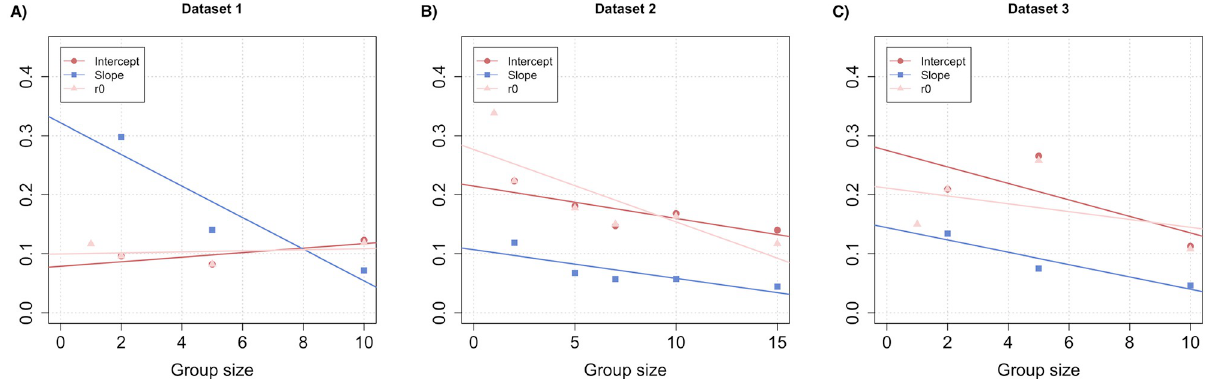
Fig 6. Slopes, intercepts and r0 values of the alarm pheromone dose-response curve as a function of group size, for all 3 datasets. The slopes and intercepts are based on the linear model, while the r0 value is estimated from the agnostic model. Pearson’s r test; dataset 1 (A): slopes ρ = − 0.9332609, p = 0.1169501, intercepts ρ = 0.7495004, p = 0.7697062, r0 ρ = 0.2101355, p = 0.6050677; dataset 2 (B): slopes ρ = − 0.8315731, p = 0.0404234, intercepts ρ = − 0.8248105, p = 0.04283618, r0: ρ = − 0.8208478, p = 0.02263414; dataset 3 (C): slopes ρ = − 0.9426515, p = 0.1083237, intercepts ρ = − 0.730198, p = 0.2394278, r0 ρ = − 0.4074521, p = 0.296274.